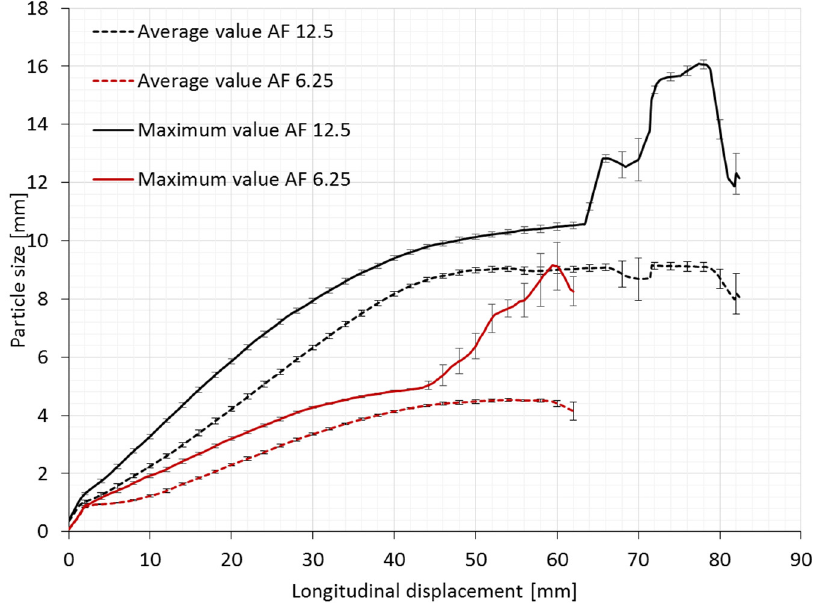
Figure 8. The relationship between the particle sizes and longitudinal displacement.